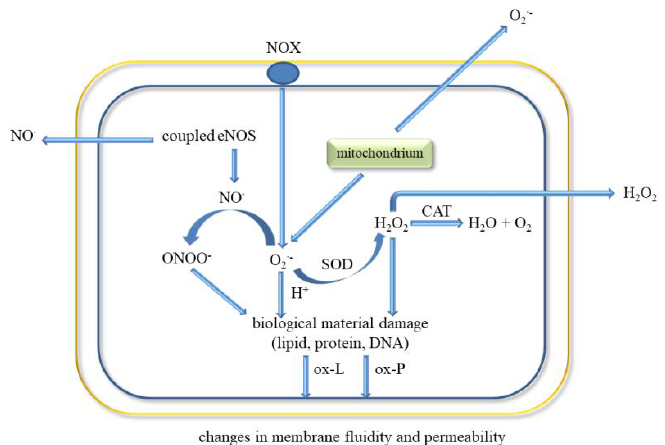
Figure 3. ROS release and oxidative biological material damage in endothelial cell. Abbreviations: catalase (CAT), water (H 2 O), hydrogen peroxide (H 2 O 2 ), endothelial nitric oxide synthase (eNOS), nitric oxide (NO • ), NADPH oxidase (NOX), oxygen (O 2 ), superoxide anion radical (O 2 •− ), peroxynitrite (ONOO − ), oxidised lipids (ox-L), oxidised proteins (ox-P), superoxide dismutase (SOD).